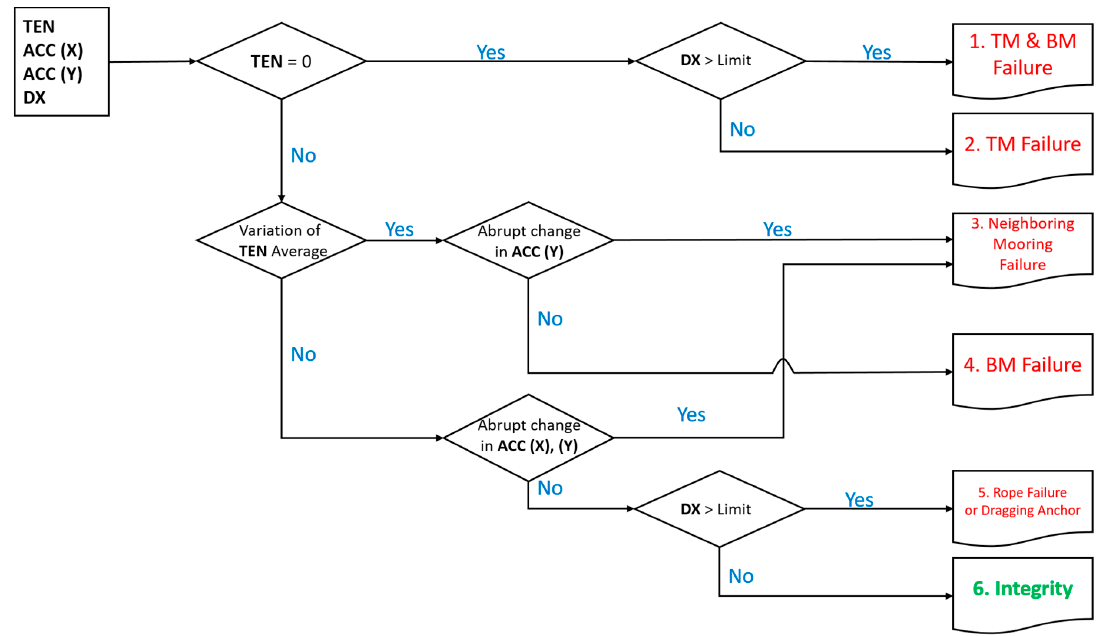
Figure 19. Failure detection algorithm.